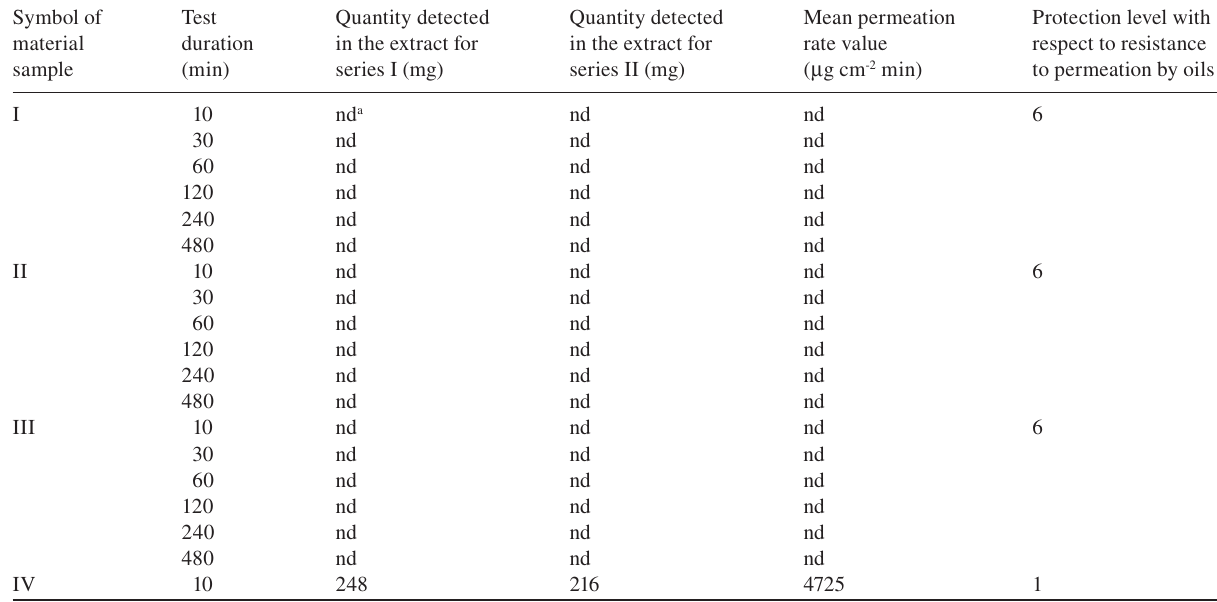
Table 5 Results obtained for the tested material samples of protective gloves. Symbol